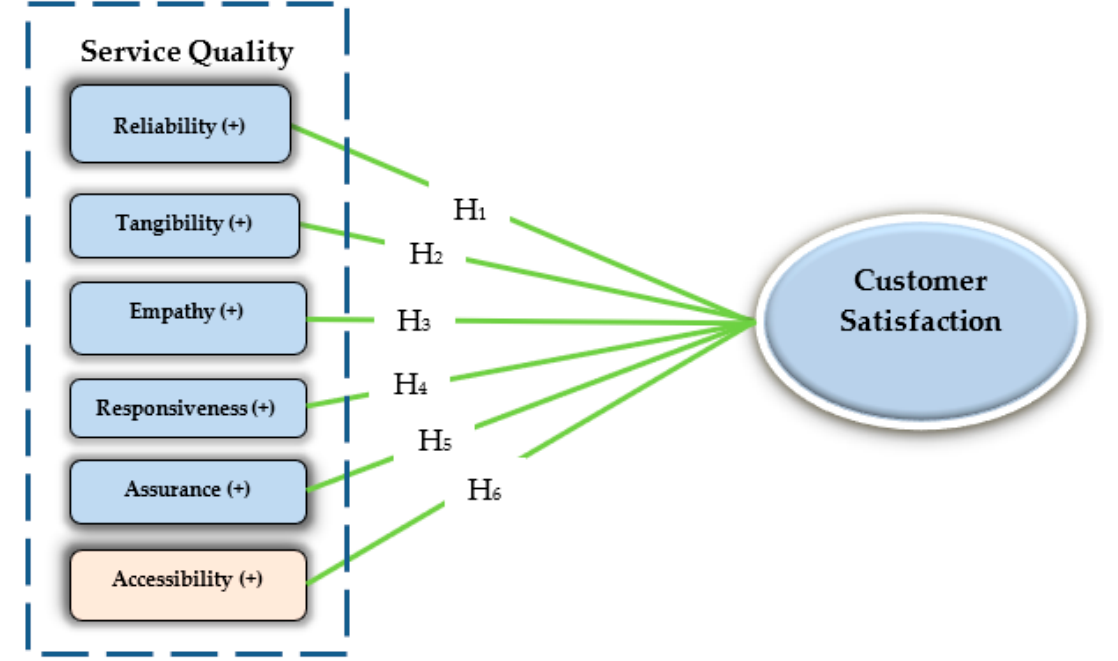
Figure 1. A research framework for service quality and customer satisfaction. Source: Modified from Cronin and Taylor (1992).